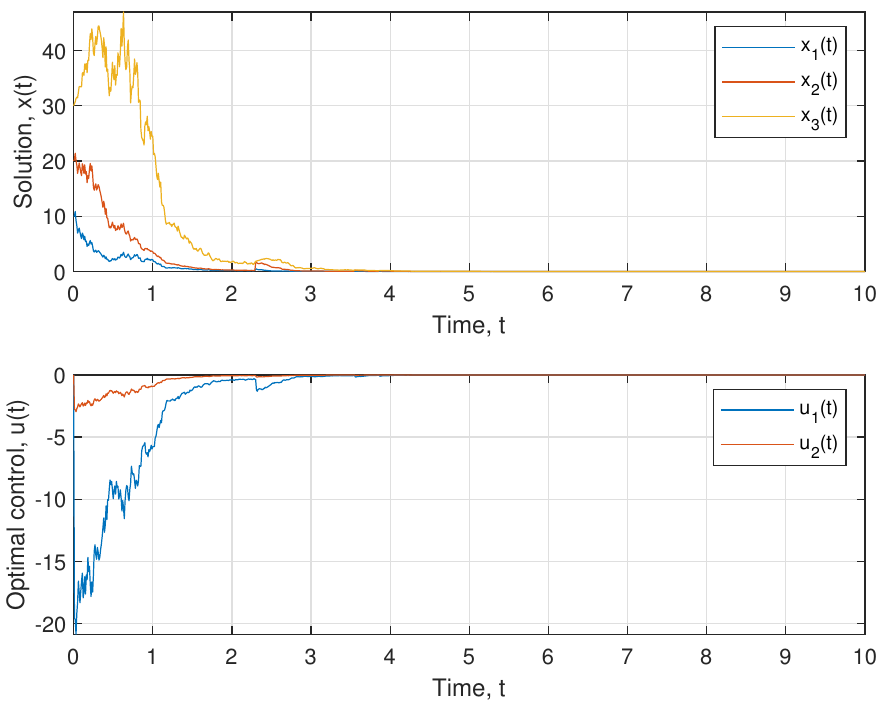
Figure 1. Realizations of the solution and optimal control with initial conditions ( 10,20,30 )